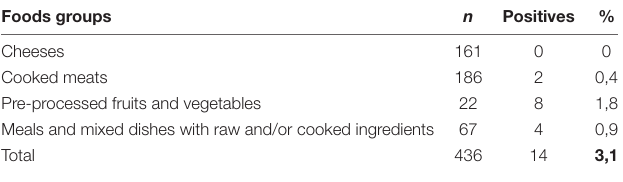
TABLE 1 | Positivity of Listeria monocytogenes in risk food